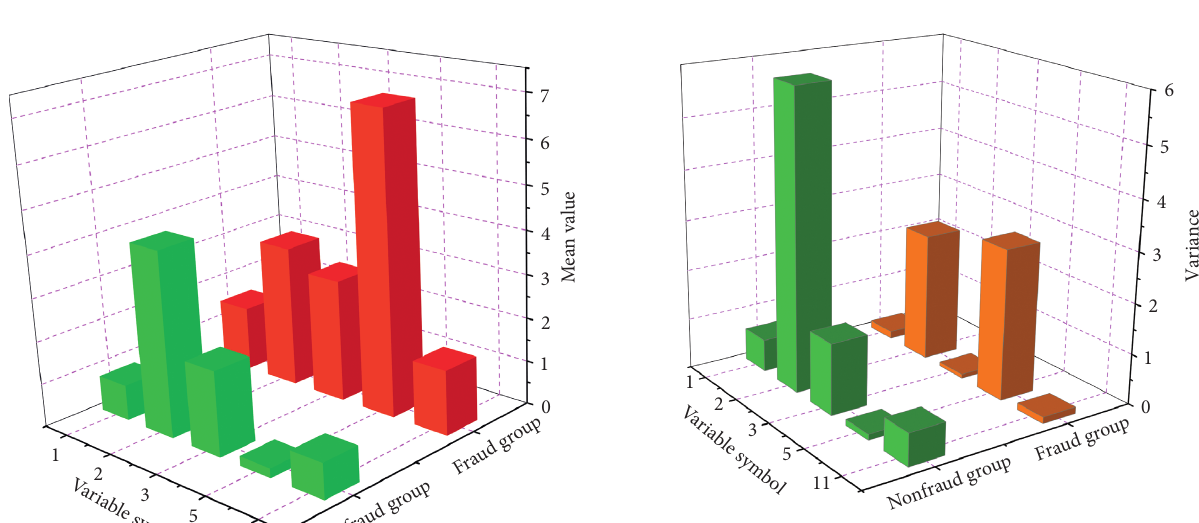
Figure 13: Variance statistics of different